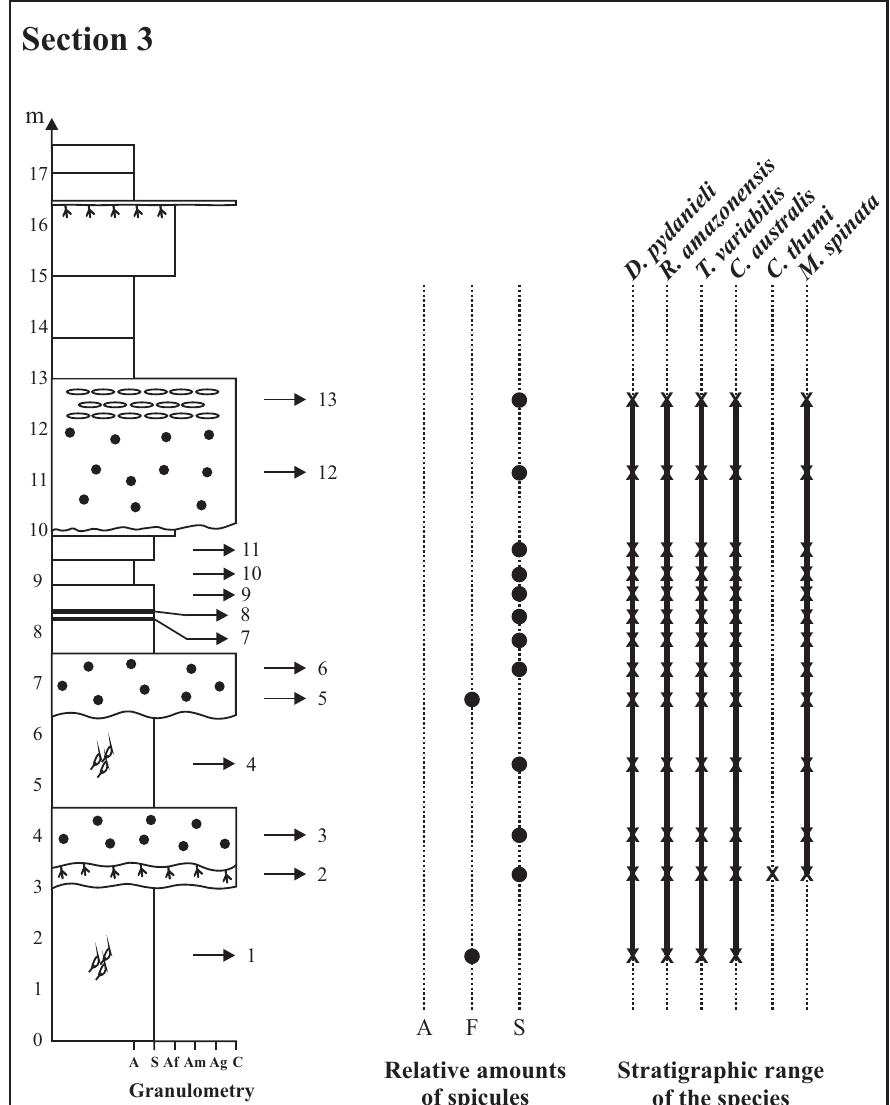
Fig. 8. Profile of Section 3 (meters) vis-a-vis the corresponding relative amounts of sponge spicules (A, absent; F. few; S, spongofacies) and stratigraphic range of the identified species. (X, occurrence of a particular species; A, argillite; S, siltstone; Af, fine sandstone; Am, medium sandstone; Ag, coarse sandstone; C, conglomerate). Legend of rocks as Figure 3. From V.S.M., unpublished